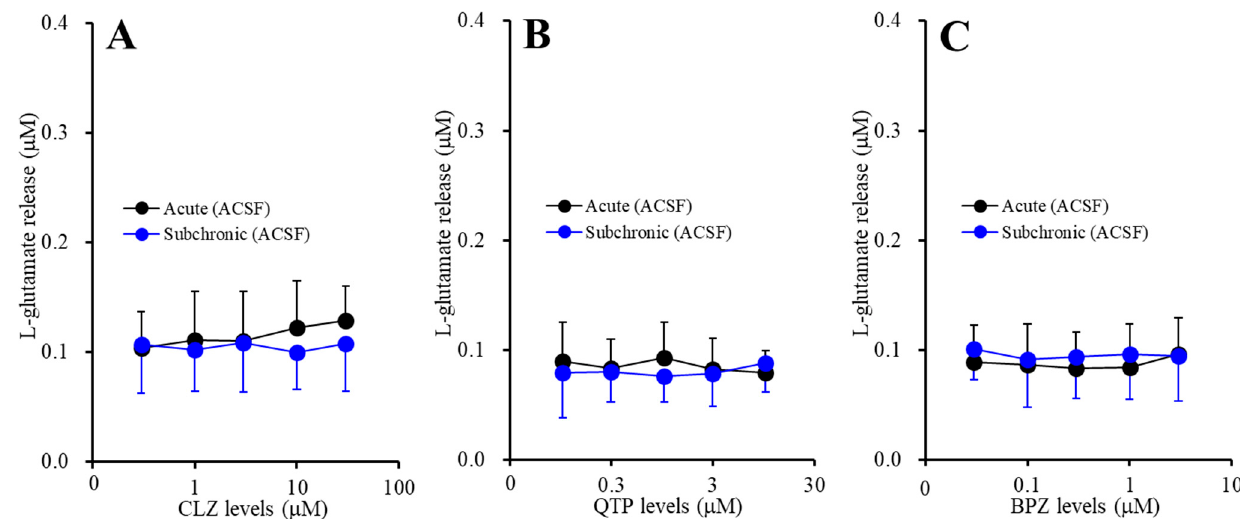
Figure 1. Concentration-dependent effects of the acute (black circles) and subchronic (blue circles) administrations of ( A ) clozapine (CLZ: 1, 3, 10 and 30 μ M), ( B ) quetiapine (QTP: 0.3, 1, 3 and 10 μ M) and ( C ) brexpiprazole (BPZ: 0.1, 0.3, 1 and 3 μ M) on the basal astroglial L -glutamate release. Ordinate: mean ± SD ( n = 6) of the basal astroglial L -glutamate release ( μ M), and abscissa: concentration of CLZ, QTP and BPZ ( μ M).